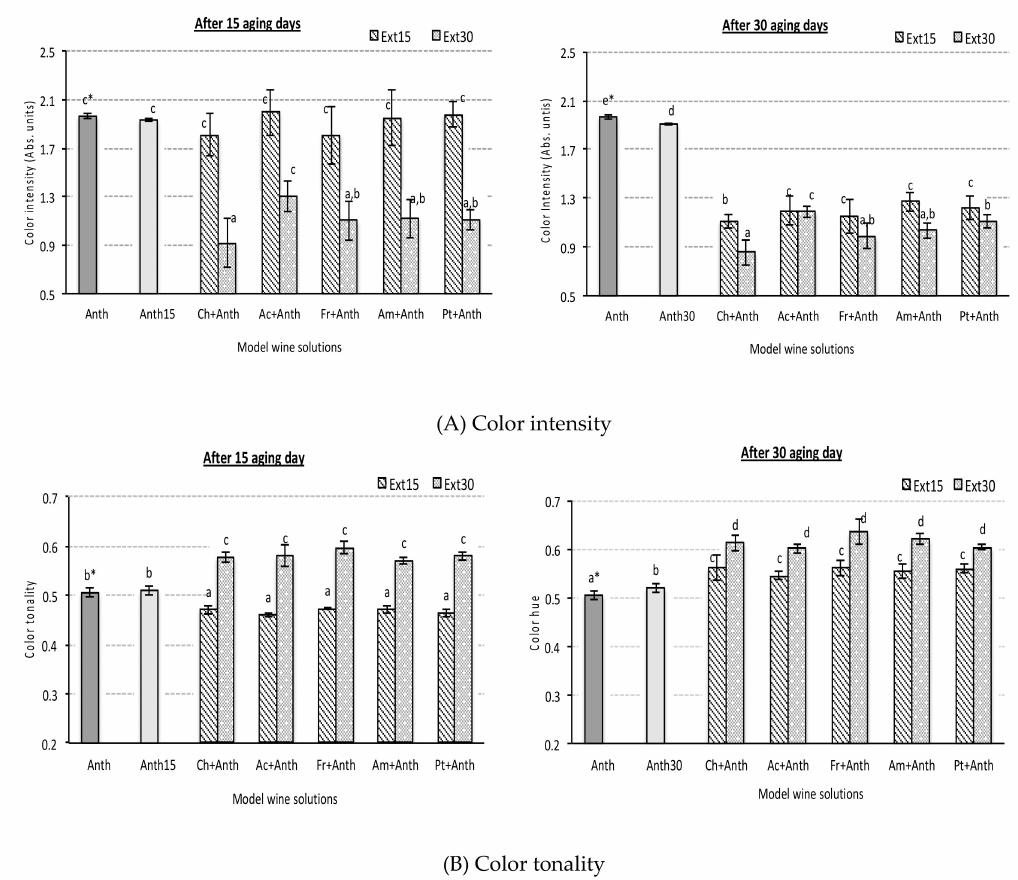
Figure 1. Color intensity ( A ) and tonality ( B ) values in red synthetic wine solutions containing di ff erent wood chip species and anthocyanin grape skin extracts after 15 and 30 aging days (sample codes see Table 1). All data express the average of four replicates ± standard deviation; * data points showing the same letter are not significantly di ff erent ( p <